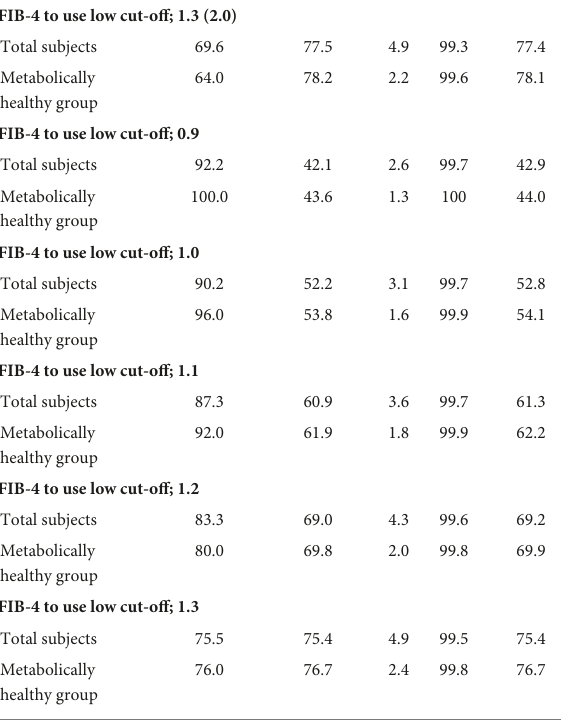
TABLE 3 Comparison of diagnostic performance for advanced hepatic fibrosis (MRE cut-off values ≥ 3.6) according to the various cut-off values of